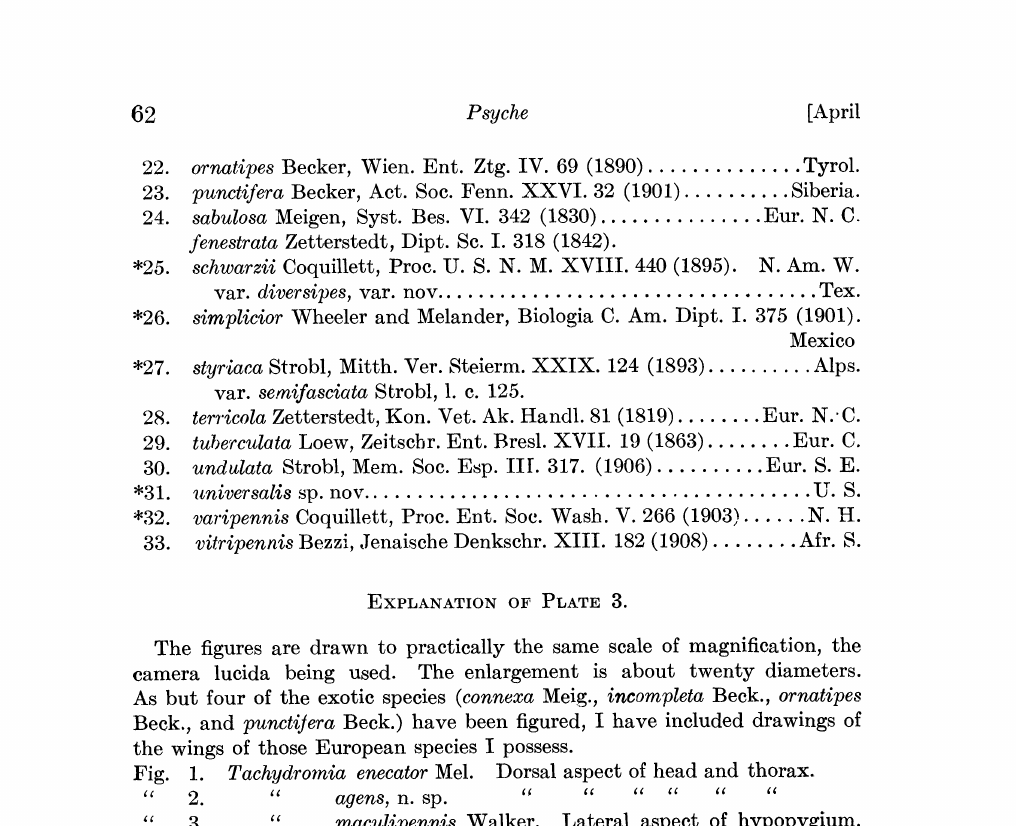
Fig. 1. Tachydromia enecator Mel. Dorsal aspect of head and